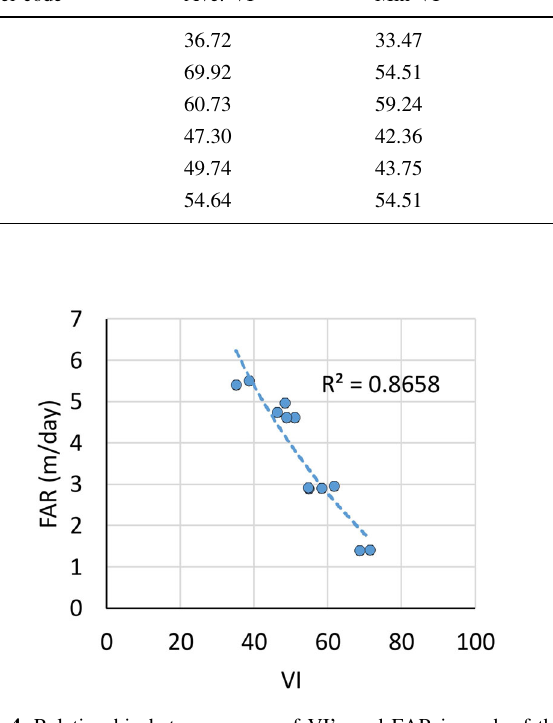
Table 7 Description of determined VI’s for considered panels in Parvadeh-I coal mine (remove outlier data from E 3 ) Panel code